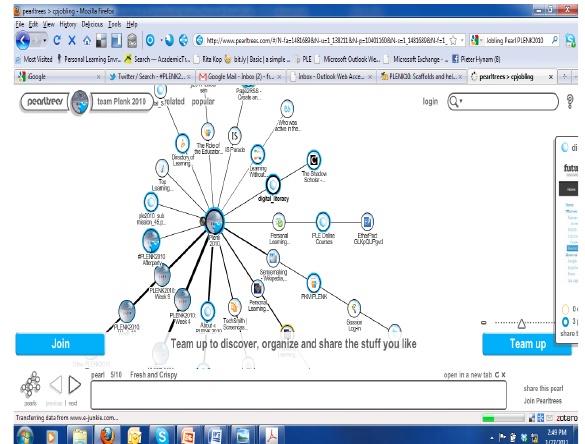
Figure 3 . Pearltrees as a curation